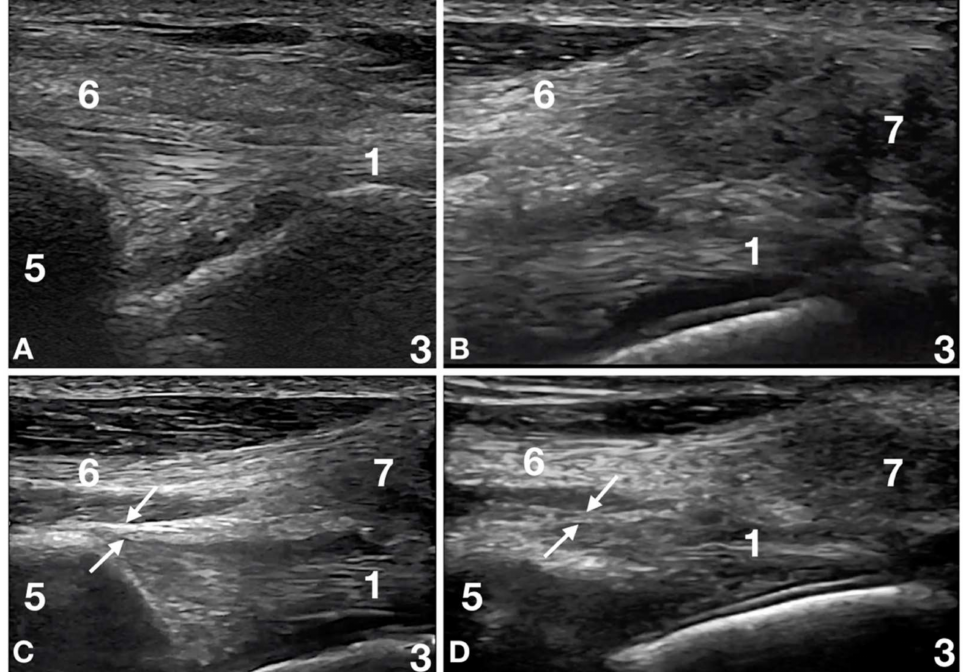
Figure 2. Images of the left shoulder at the level of the biceps tendon origin and supraspinatus humeral insertion of patient number 14 at Time 0, Time 2, Time 4 and Time 6. ( A ) Time 0: the supraglenoid tubercle (5) with the origin of the biceps tendon (1) is seen. There is no clear definition between the biceps tendon (1), the joint capsule (between arrows in panels c and d), and the tendinous (6) and fibro-cartilaginous (7) (visible in panel b, c and d) portions of the supraspinatus tendon. At dynamic examination, there were no relative motions between the biceps and the supraspinatus tendons. The joint capsule was not identified between these two structures. This condition is called adhesive capsulitis [20]. ( B ) Time 2: There is a better definition between the biceps tendon (1) and the tendinous (6) and fibrocartilaginous (7) portions of the supraspinatus tendon; however, these structures show adhesions at dynamic examination. The joint capsule (between the arrows in panels C , D ) is not identified. The adhesive capsulitis is still present. ( C ) Time 4: There is a better definition between the biceps tendon (1) and the tendinous (6) and fibrocartilaginous (7) portions of the supraspinatus tendon, and no adhesion is seen at dynamic examination. The joint capsule (between the arrows) is thickened and irregular but is identified as an independent structure. The adhesive capsulitis is resolved. ( D ) Time 6: the biceps tendon (1) is clearly defined with a richer fibrillar pattern. The joint capsule (between the arrows) is better defined, less thickened and more regular than before. No interference is seen at dynamic examination between the joint capsule and the biceps tendon (1). No interference is visible between the joint capsule and the tendinous (6) and fibrocartilaginous (7) portions of the supraspinatus